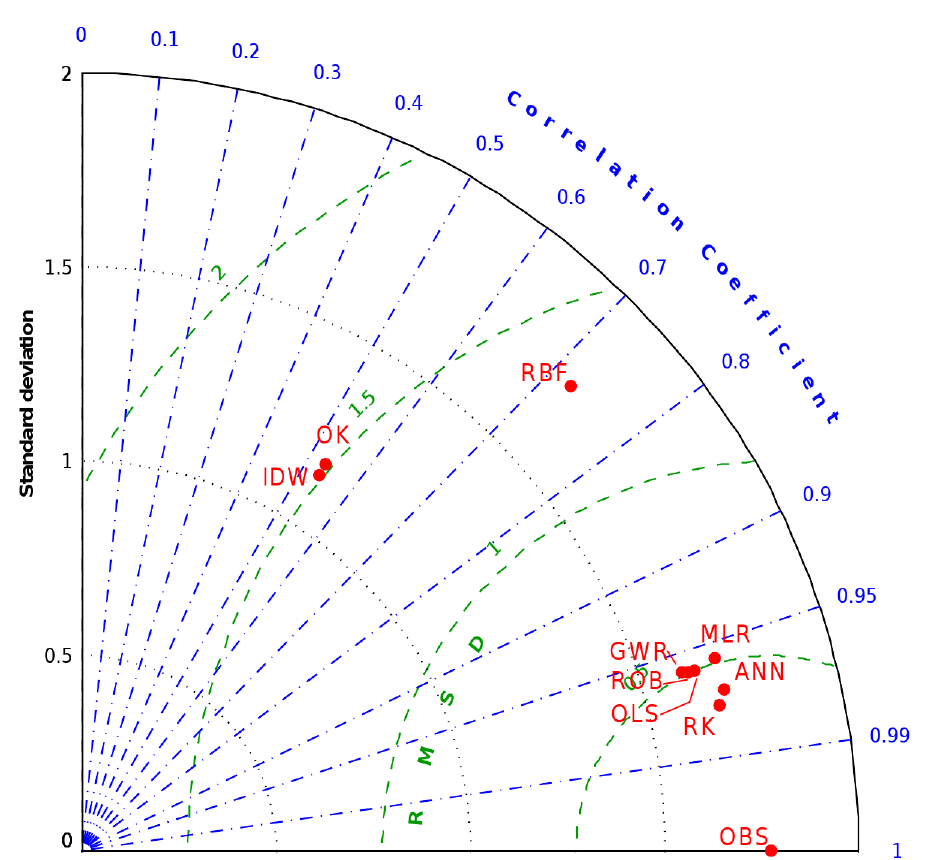
Figure 5. Taylor diagram for mean annual temperature interpolation models. The label OBS is used to represent the reference data ( i.e. , observations) to which estimator performances are